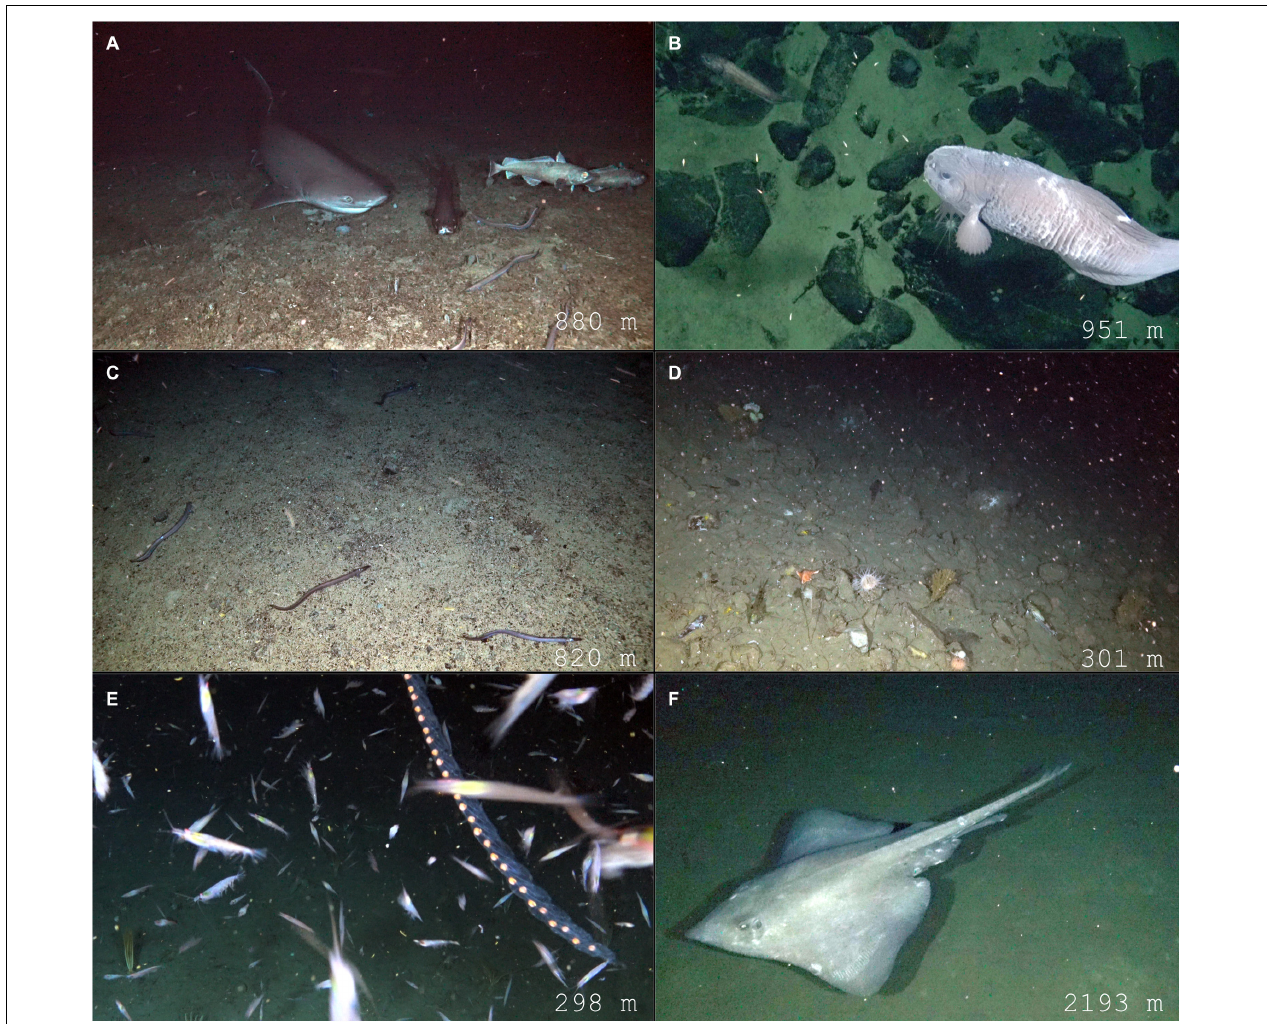
FIGURE 3 | Example imagery from NGS deep-sea camera system: (A) Hexanchus griseus , Dalatias licha , Synaphobranchidae, and Mora moro , at 880 m on a seamount in the Azores; (B) Liparid at 951 m at Malpelo Island; (C) Elongate taxa, Synaphobranchus sp., at 820 m in the Azores; (D) Benthic taxa in background of a frame can be difficult or impossible to confidently identify; 301 m on the Antarctic shelf; (E) Siphonophora and light-attracted krill (Eupahsiidae); 298 m on the Antarctic shelf; (F) Bathyraja spinosissima , at 2193 m at Malpelo